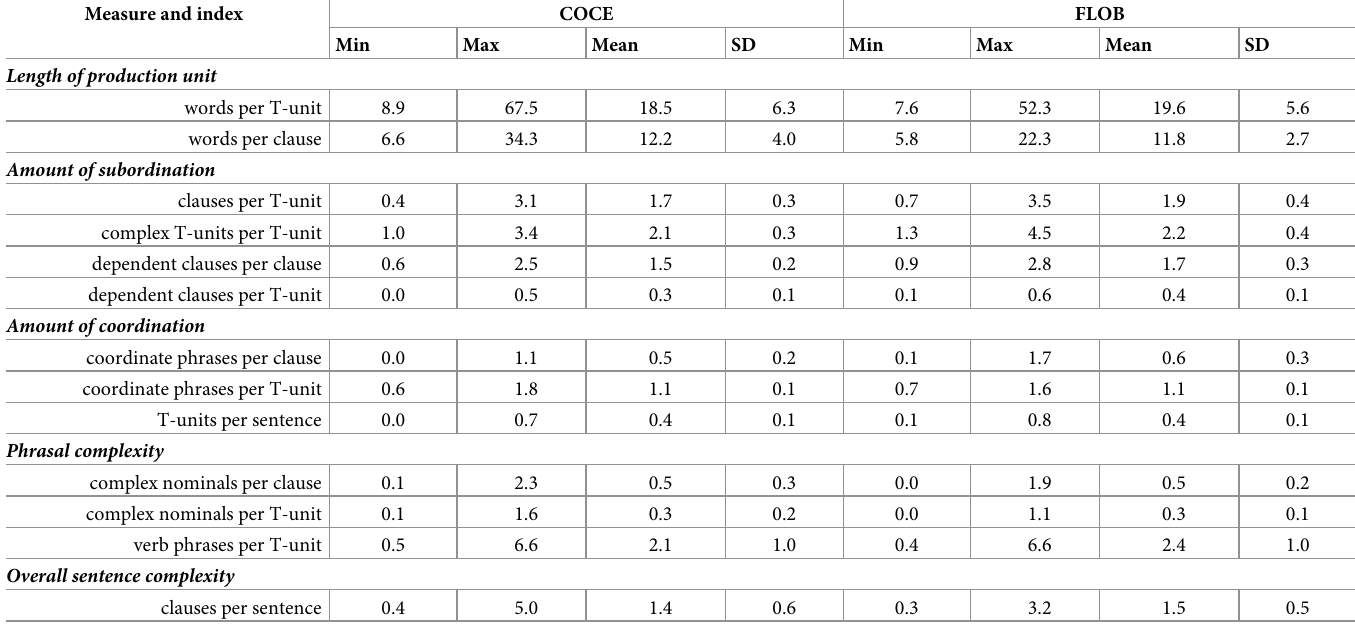
Table 2. Descriptive statistics for the 13 measures in the five subconstructs of syntactic